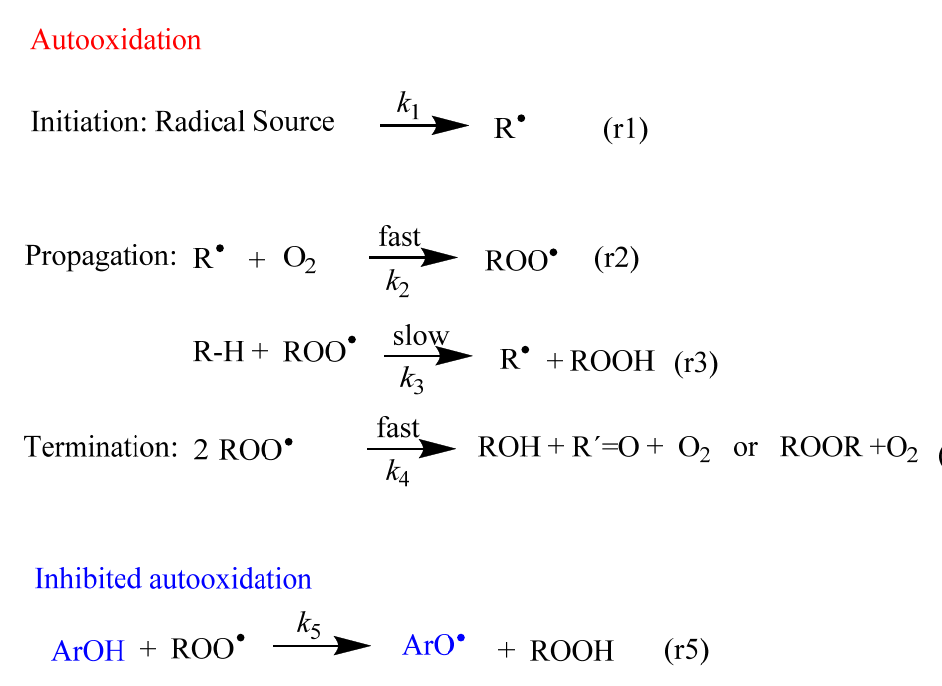
Figure 1. Fundamental steps of the lipid autooxidation and inhibition reactions. The main inhibition mechanism comprises the transfer of an H atom from a phenolic antioxidant (ArOH) to the chain carrying a free radical (ROO • ). R-H stands for lipid molecule, and R • , ROO • and RO • are the derived lipoid, peroxyl and alkoxyl radicals,